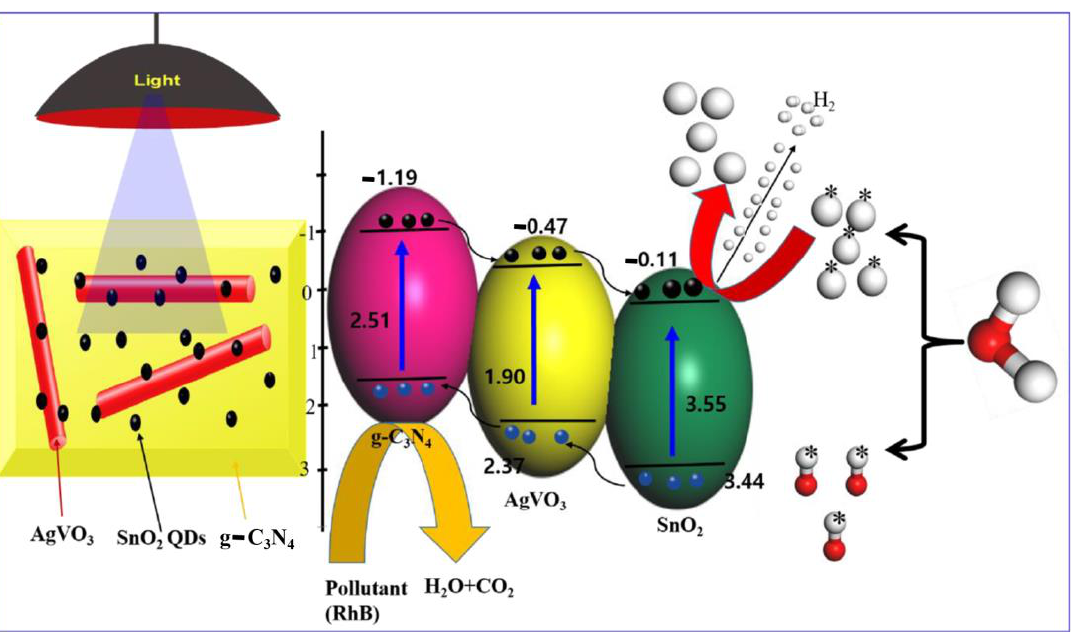
Figure 7. Photocatalytic mechanism of the ternary photocatalyst (SnO 2 /AgVO 3 /g-C 3 N 4 ) [24], Copyright 2019, Springer. Table 4. Detailed description of recent research on the photocatalytic abilities of SnO 2 QD-based ternary nanocomposites.